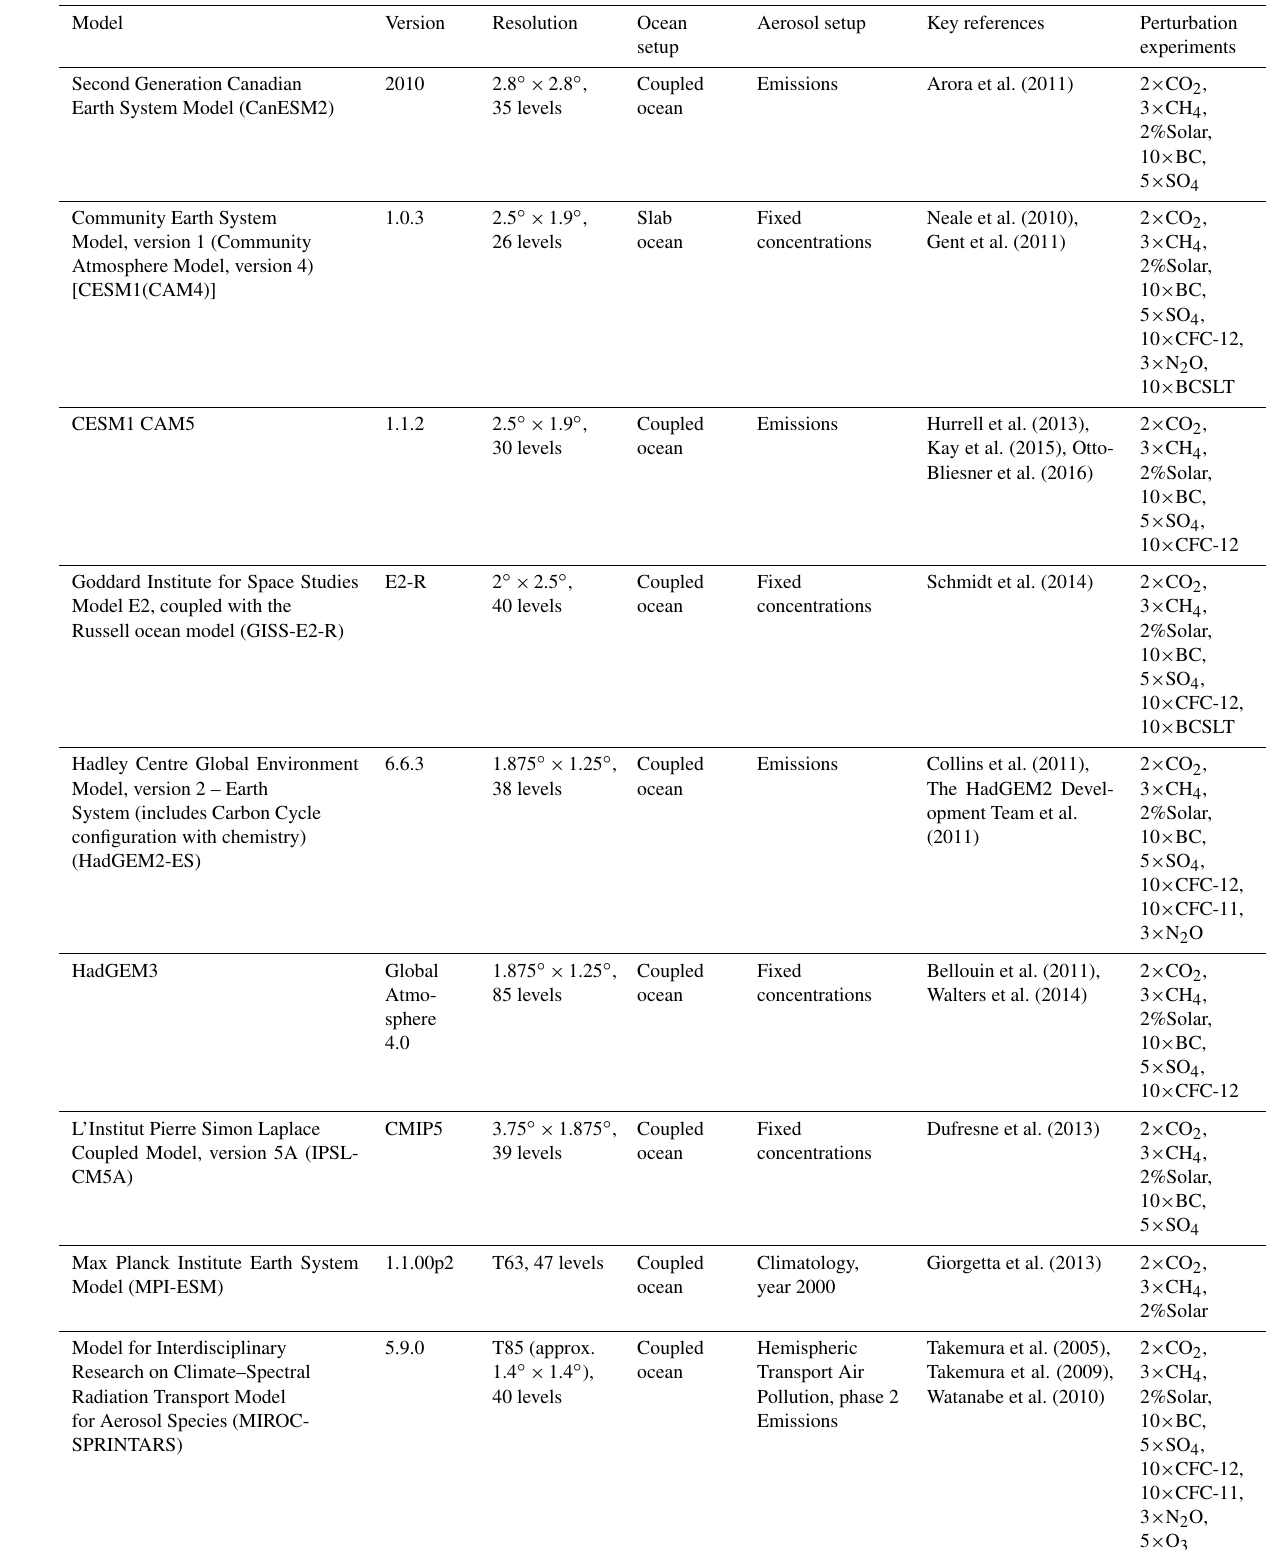
Table 1. Columns 1–6: description of PDRMIP models (Myhre et al., 2017). © American Meteorological Society. Used with permission. Column 7: list of perturbation experiments used in this